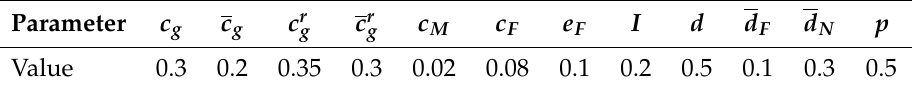
Table 1. Initial